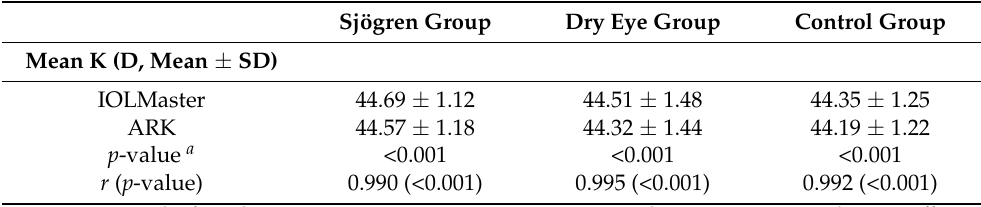
Table 3. Mean Keratometry Values Measured by the IOLMaster and ARK.